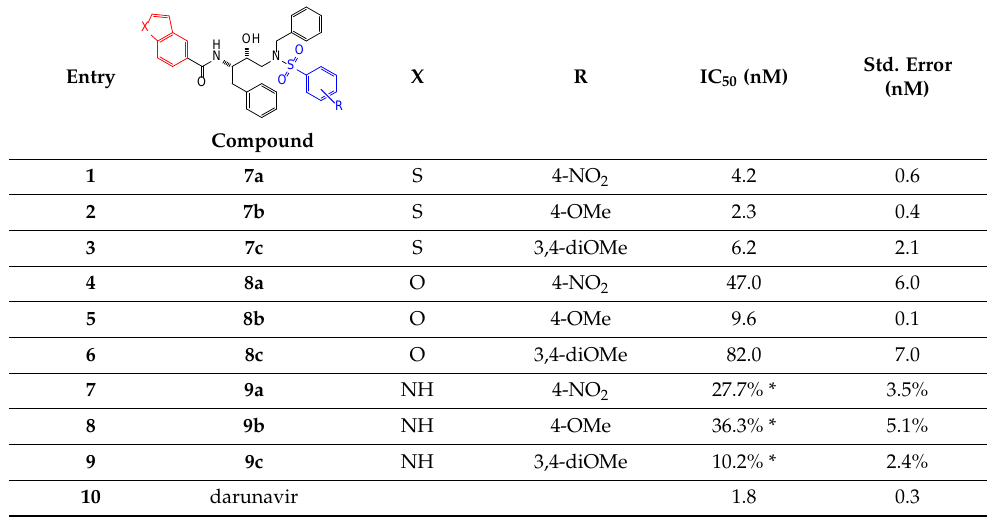
Table 1. In vitro inhibition activity of compounds 7 .